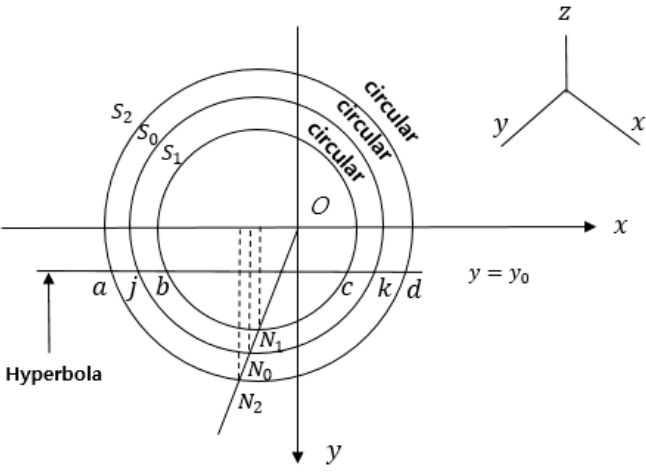
Figure 6. Projection diagram of disc. The intersections between the vertical lines of N 0 , N 1 , and N 2 with the plane z = z0 are the center points of jk, bc, and ad, and the apexes N i of the minor axis of the intersection constitute the line N i O . During the valve opening and closing, point P(y, z), which is on the hyperbola ab, rotates about O 0 with a speed of PN perpendicular to O o P , as illustrated in Figure 7. The angle of θ in Equation (17) is the friction angle between the sealing pair ( PM , PN ). The angle of β in Equation (18) is between PM and the axial line crossing the seal point and parallel with the x -axis. The angle of θ 1 in Equation (19) is between O o P and the vertical line crossing the rotary center ( O 0 ). The vertical line intersects the rotation center, so the disc can quickly get out from the seal, and the friction moment reduces [18,19].